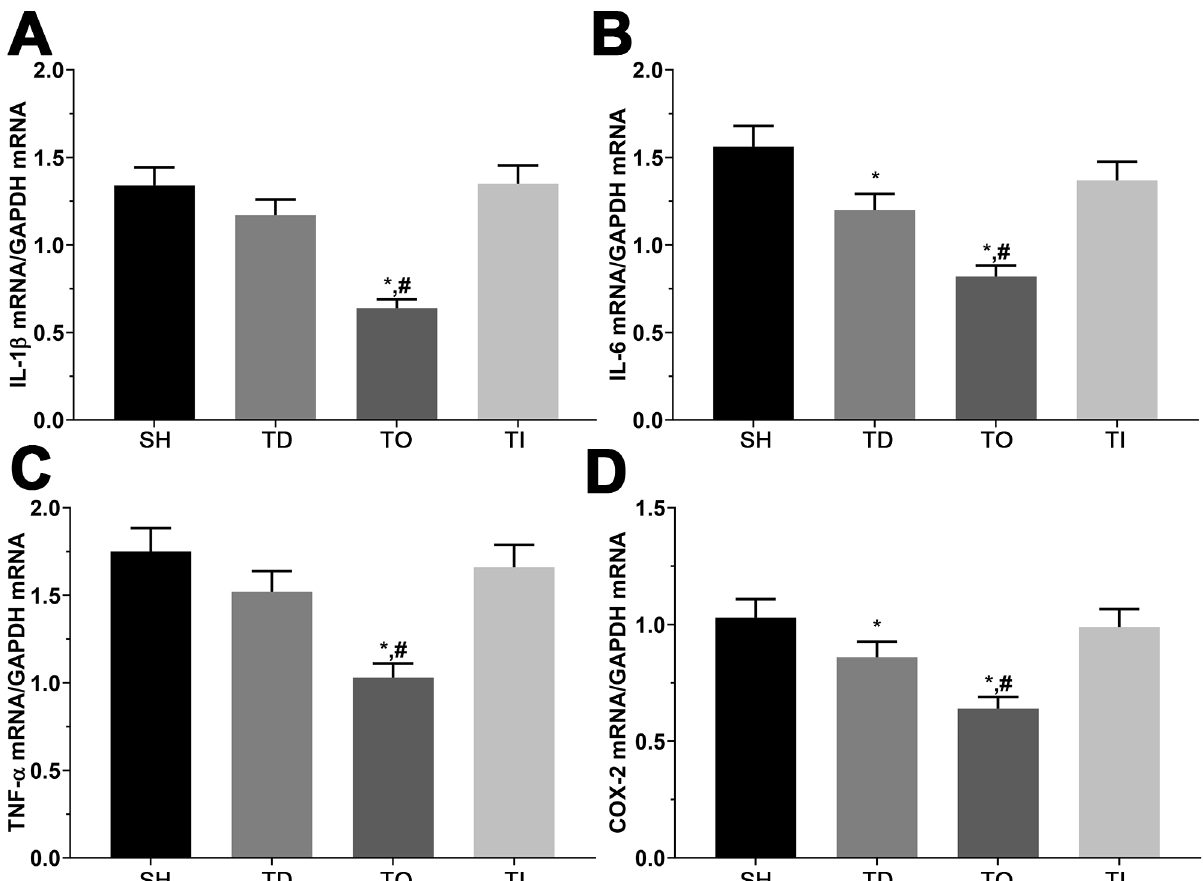
Figure 4 – Detection of pro-inflammatory factors in brain tissues of rats. (A) Expression of IL-1b mRNA in SH, TD, TO and TI group of rats. (B) Expression of IL-6 mRNA in SH, TD, TO and TI group of rats. (C) Expression of TNF-A mRNA in SH, TD, TO and TI group of rats. (D) Expression of PTGS2 mRNA in SH, TD, TO and TI group of rats. Data was presented as mean ± SD, each experiment was repeated for three times. *P<0.05 vs SH group of rats. #P<0.05 vs signal dezocine treatment group. NC: normal group, DT: dezocine treatment group, DO: dezocine treatment combined with RAPGEF3 overexpression group, DI: dezocine treatment combined with RAPGEF3 inhibition group. SH: sham group, TD: dezocine treatment group, TO: dezocine treatment combined with RAPGEF3 overexpression group, TI: dezocine treatment combined with RAPGEF3 inhibition